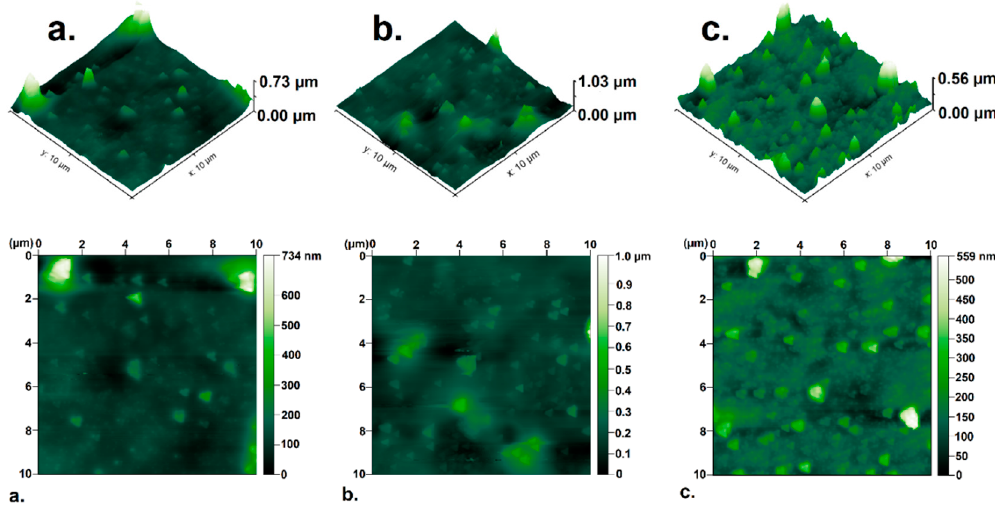
Figure 11. AFM images of the ( a ) PEEK/Ag0.04, ( b ) PEEK/Ag0.08 and ( c ) PEEK/Ag0.12 systems with two layers.